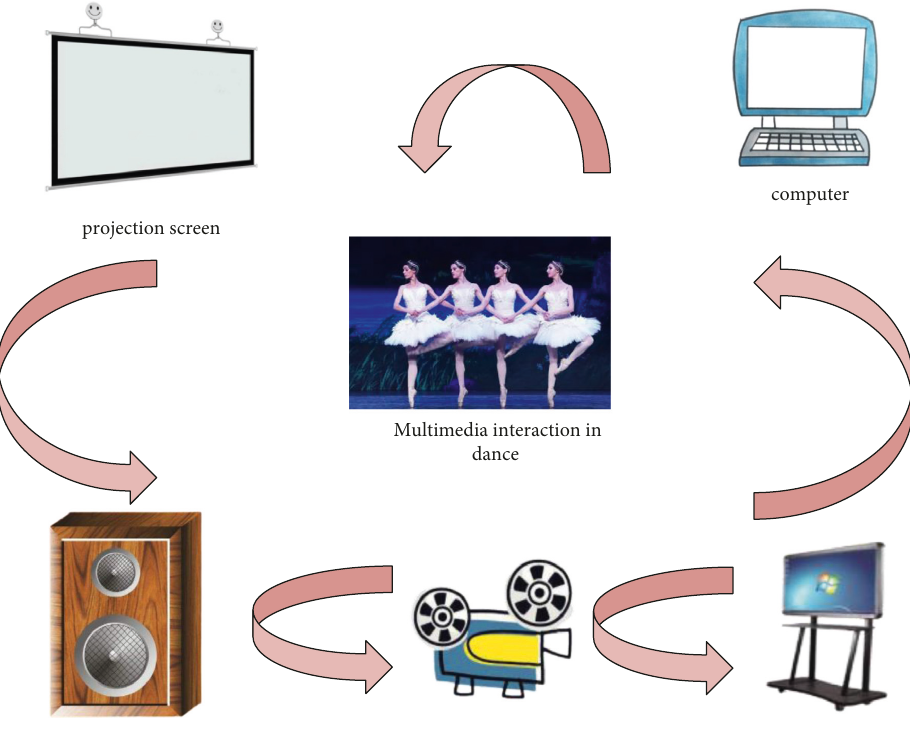
Figure 7: Interactivity of new media